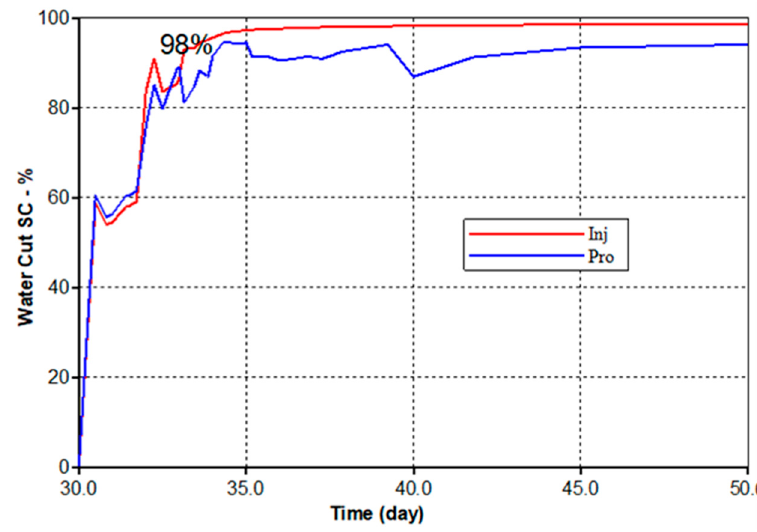
The shortest fluid replacement time is determined as produced water-cut up to 98%.